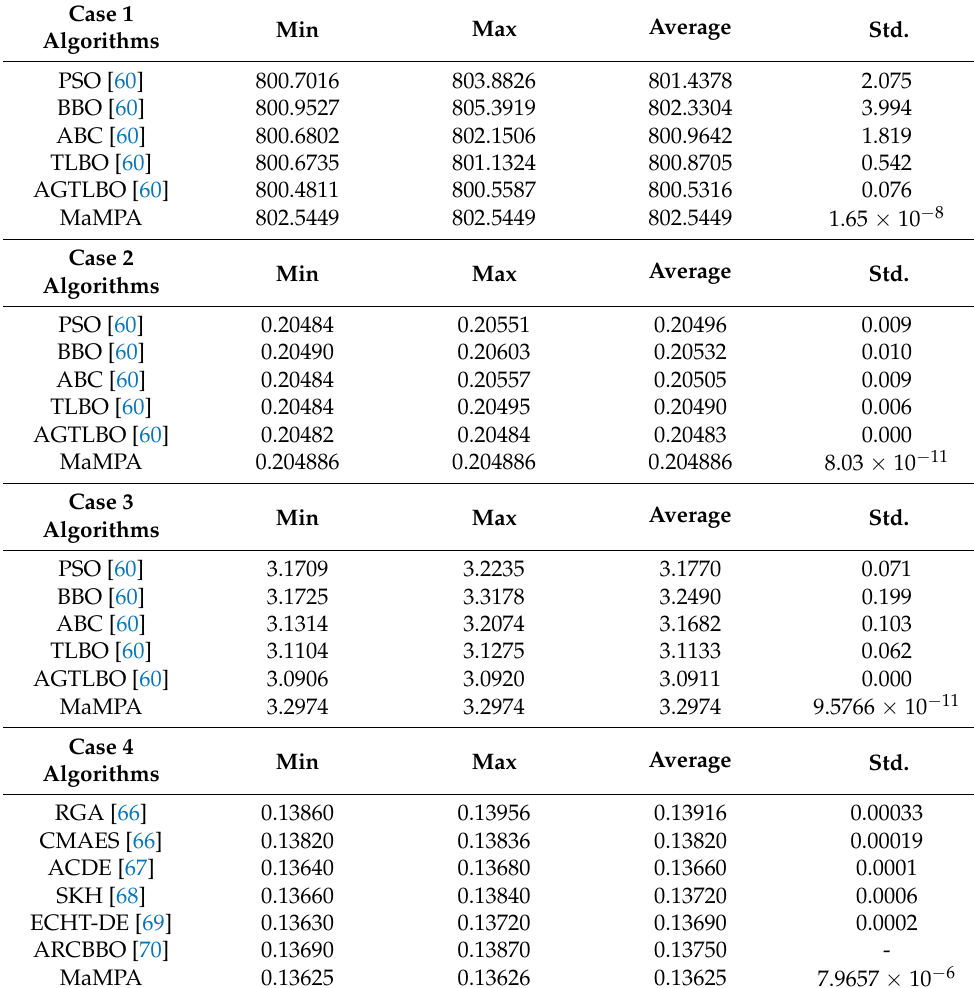
Table 9. Statistical comparison of MaMPA and other algorithms in the IEEE 30-bus